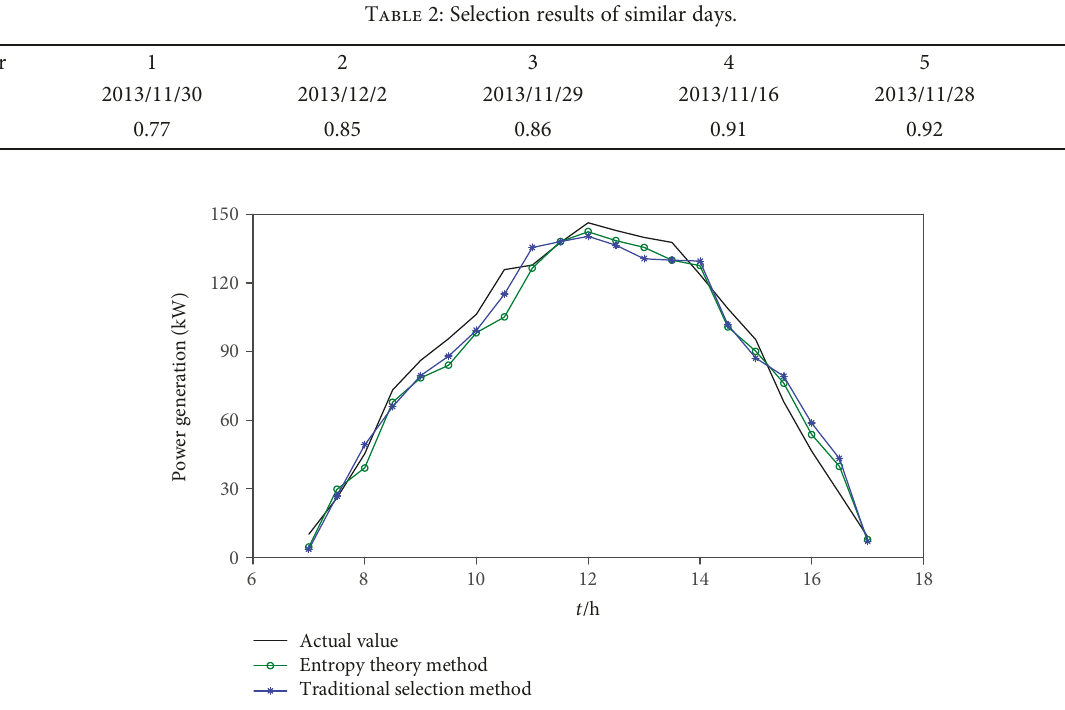
Figure 2: Prediction results of di ff erent similar day methods. Table 3: Statistics of forecasting errors for di ff erent selection